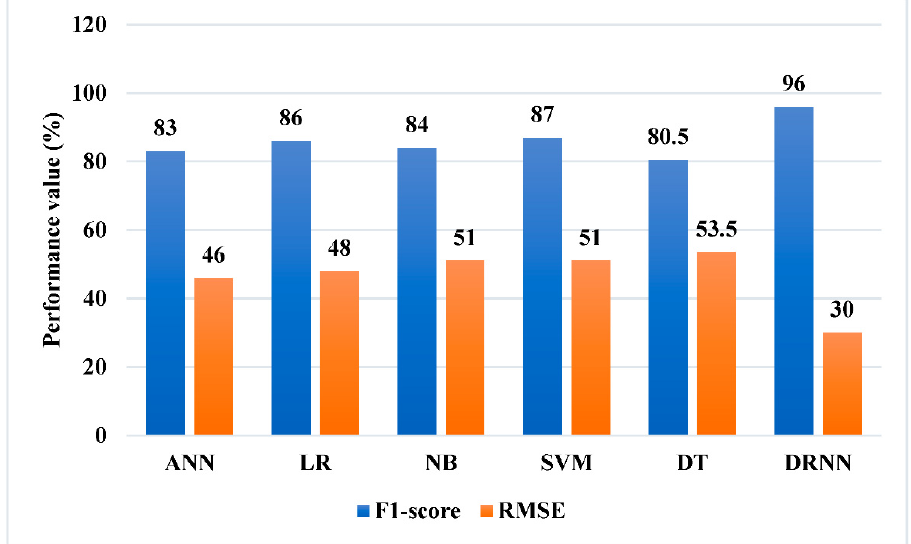
Figure 7. RMSE and F1-score of both existing and proposed techniques.